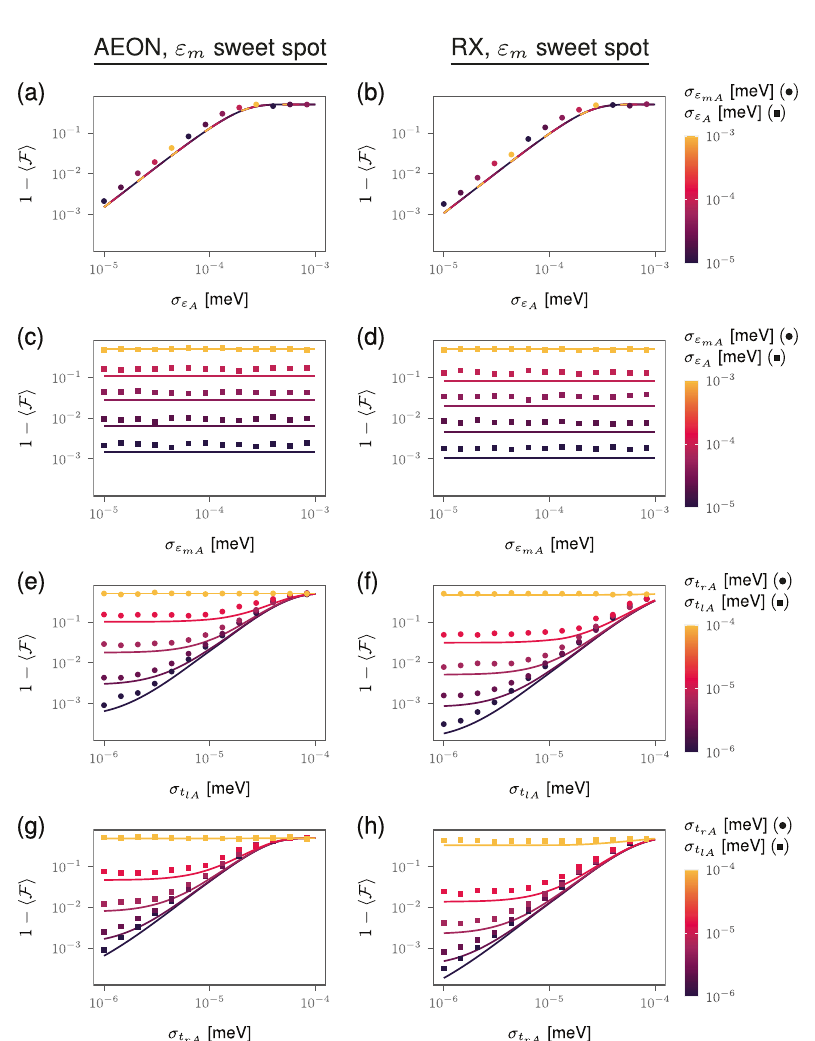
Fig. 4 Comparison of in fi delities for the fastest gate times ( k = 1) for the AEON ( t 0 = 450 ns) and RX ( t 0 = 64 ns), when the ε mA 2QSS overlaps with the ε A = 0 line. Left column (panels a , c , e , g ) are identical with panels ( c , d , g , h ) of Fig. 3. Right column (panels b , d , f , h ) are similar to panels ( k , l , o , p ) of Fig. 3, except that they are calculated for k = 1. Comparing each row, it is clear that the RX performs slightly better than the AEON, as expected for a faster